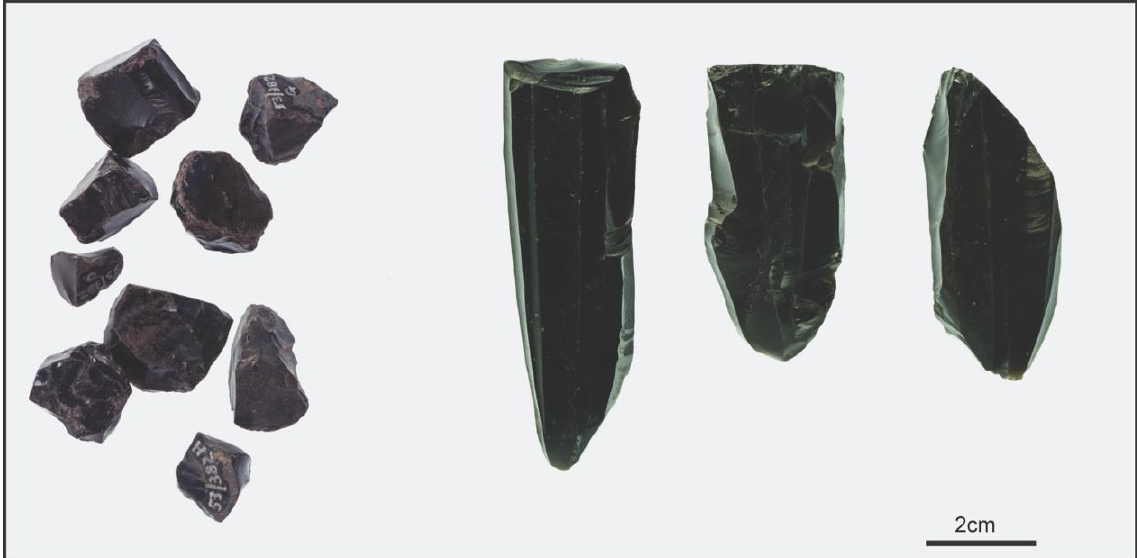
Figure 9. Cores and partially ground chunks from Arpachiyah (photographs by Stuart